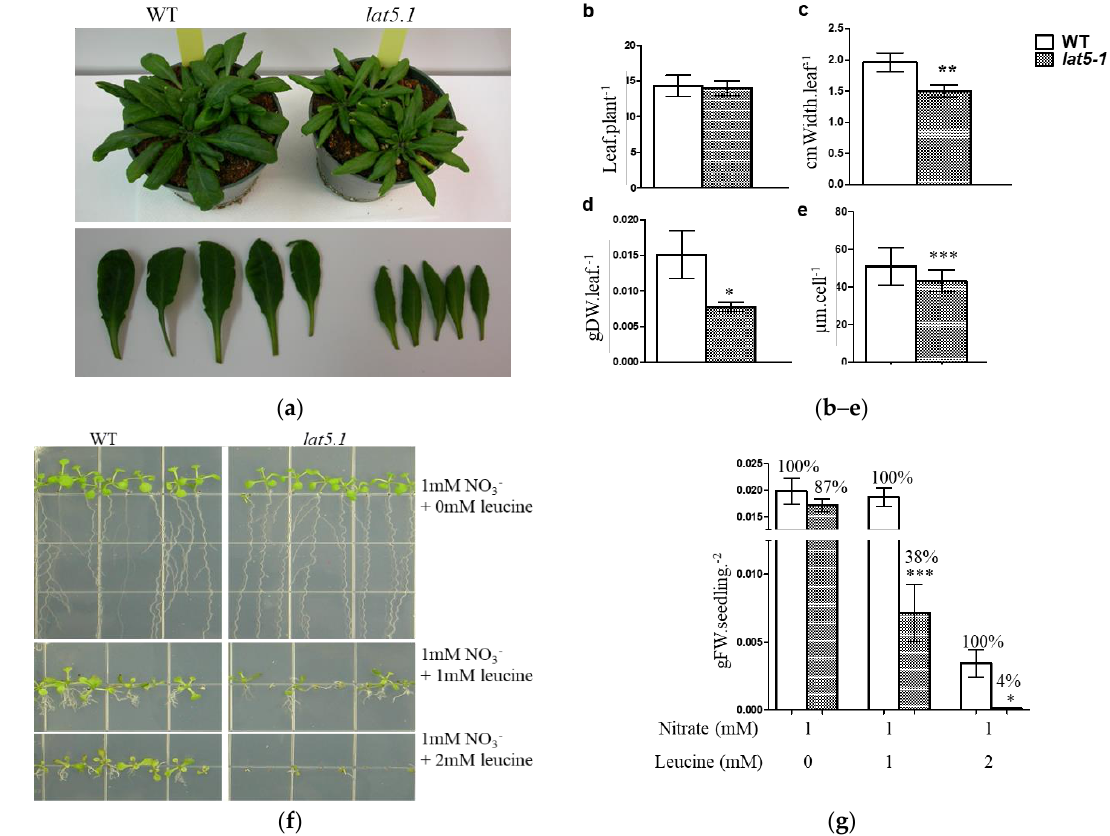
Figure 3. Phenotypic analysis of the lat5-1 on soil and plate culture. ( a ) Visual presentation of the lat5-1 showing reduced leaf growth compared to the WT; ( b ) the homozygous lat5-1 mutant plants show no difference in the total number of rosette leaves; ( c ) but show reduced leaf size, measured by the leaf width; ( d ) and reduced biomass, compared to the WT under normal growth condition on fertilized soil. Photos were taken when the plants were five weeks old. For leaf biomass, leaves were cut off and dried at 70 °C for two hours before being weighed. The error bar represents the standard deviation of five replicates. ( e ) Leaf mesophyll cell protoplasts in the lat5-1 are smaller compared to the WT. The error bar represents the standard deviation of the diameter of 100 cells from three individual plant protoplast cultures. ( f ) The mutant lat5-1 seedlings are more sensitive to exogenous leucine compared to the WT. Variable concentrations of L-leucine were added to a nitrogen-free growth medium with 1 mmol·L −1 nitrate as the source of nitrogen. ( g ) A quantitative representation shows significantly increased sensitivity of the lat5-1 seedlings to exogenous leucine compared to the WT, measured by the reduction in fresh weight of biomass. The relative percentage of growth was calculated assuming the biomass obtained by the corresponding WT as 100%. The error bar represents the standard deviation of three to five biological replications with two seedlings per replication. Photos were taken when the seedlings were two-weeks old. Each growth condition had three or more plate replications. Each growth experiment was repeated at least twice with similar results. * p < 0.05; ** p < 0.01; *** p < 0.001. DW, Dry weight; FW, Fresh weight; M, mol·L −1 . Leucine was used to investigate the role of another member of the LAT family, LAT4/PAR1, in amino acid transport [11]. For the same reason, leucine was used to investigate the role of LAT5/PUT5 in this report. While the lat5-1 showed a 13% growth reduction on 1 mM nitrate, it showed a significant 62% growth reduction compared to the WT in the presence of 1 mM leucine. In the presence of 2 mM